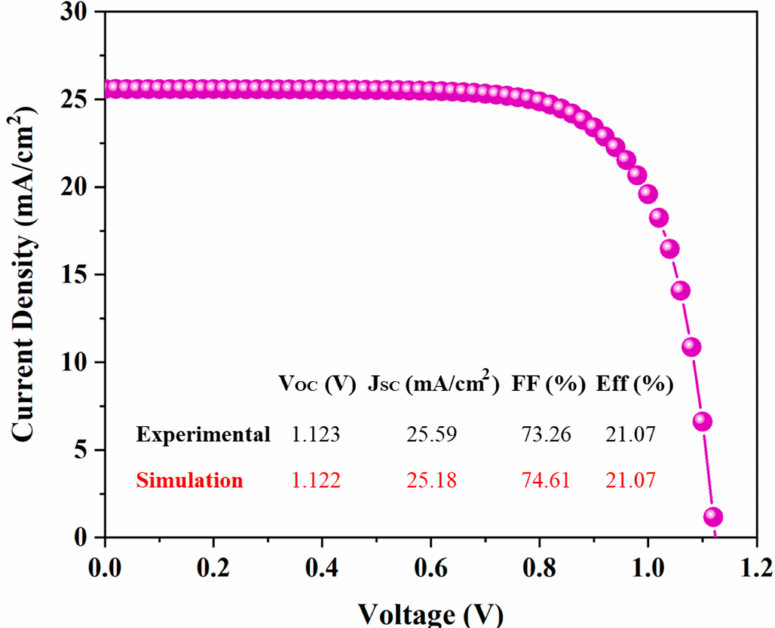
Figure 2. J-V curve for a planar perovskite solar cell with a structure of FTO/SnO 2 (90 nm)/FAPbI 3 (550 nm)/Spiro-OMeTAD (200 nm)/Au. For simulations, the physical parameters are extracted from Tables 1 and 2. The experimental data were adopted from Ref. [48].